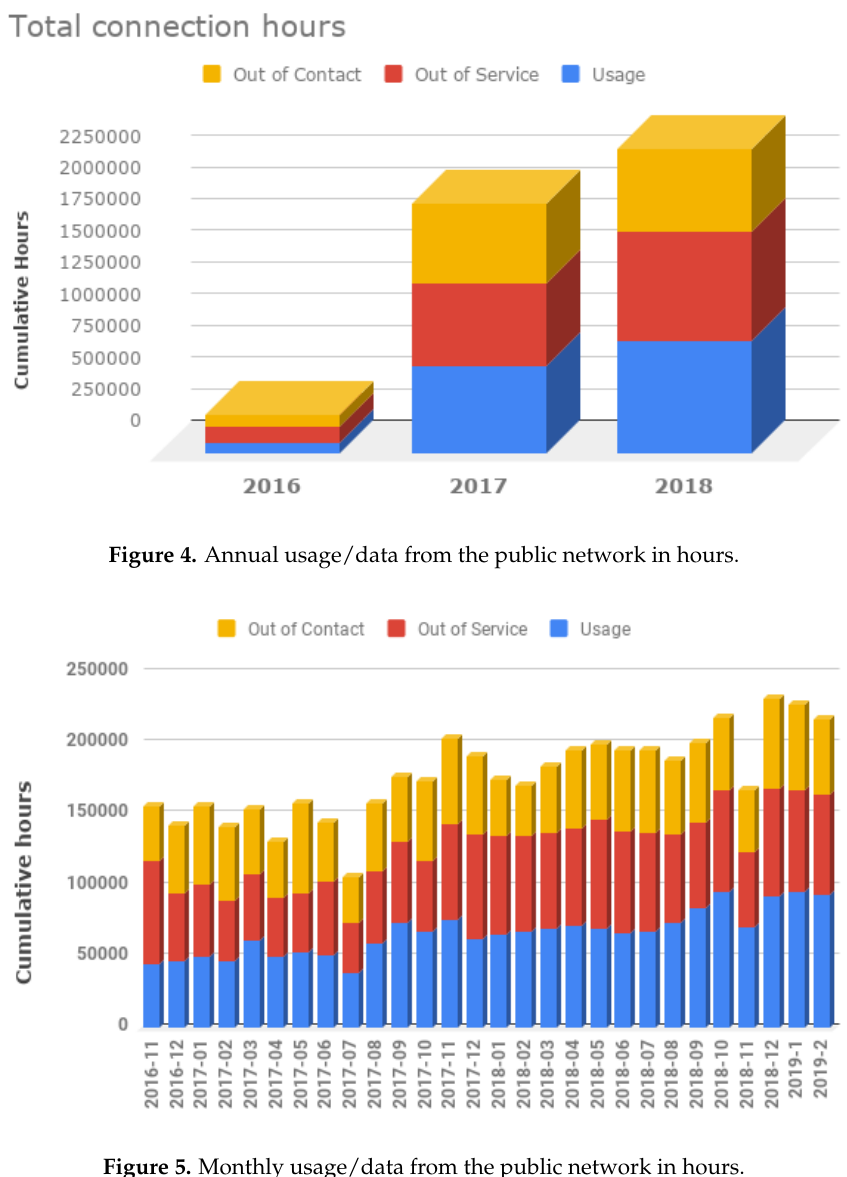
Figure 5. Monthly usage/data from the public network in hours.